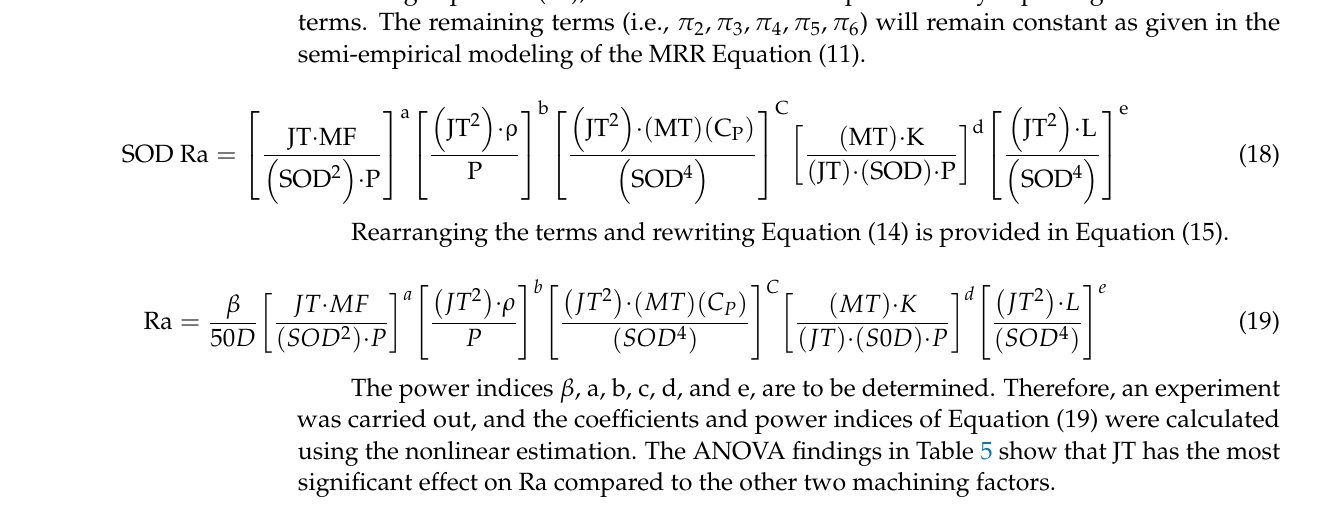
Table 5. ANOVA for